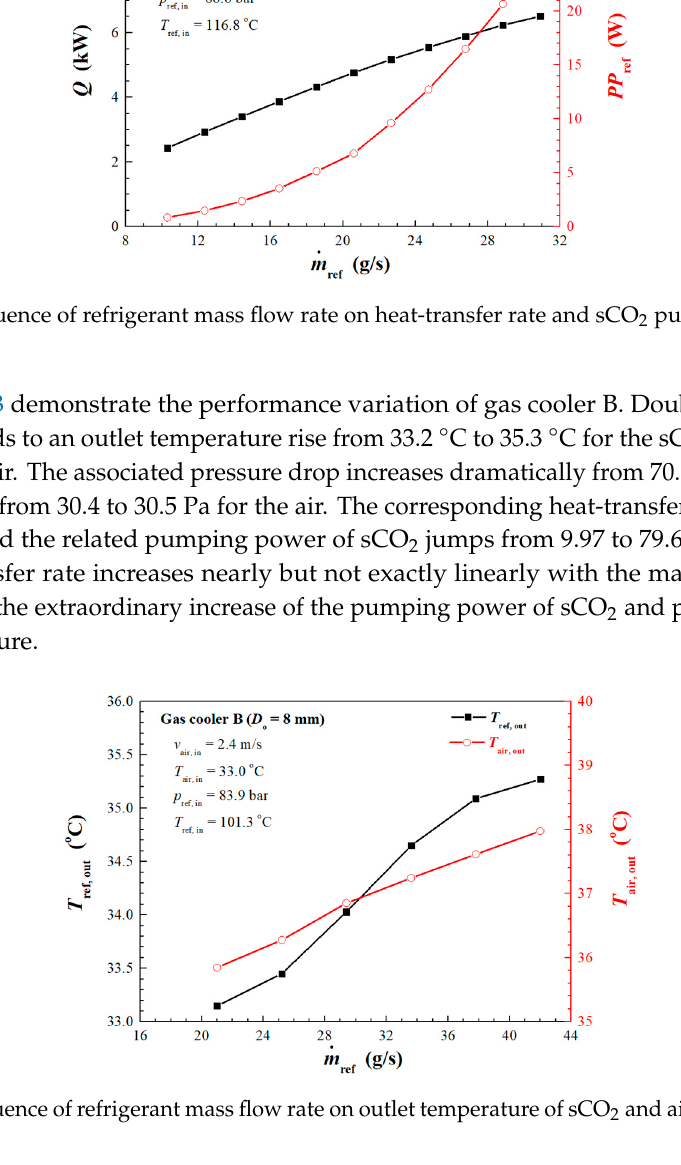
Figure 11. Influence of refrigerant mass flow rate on outlet temperature of sCO 2 and air for gas cooler B.